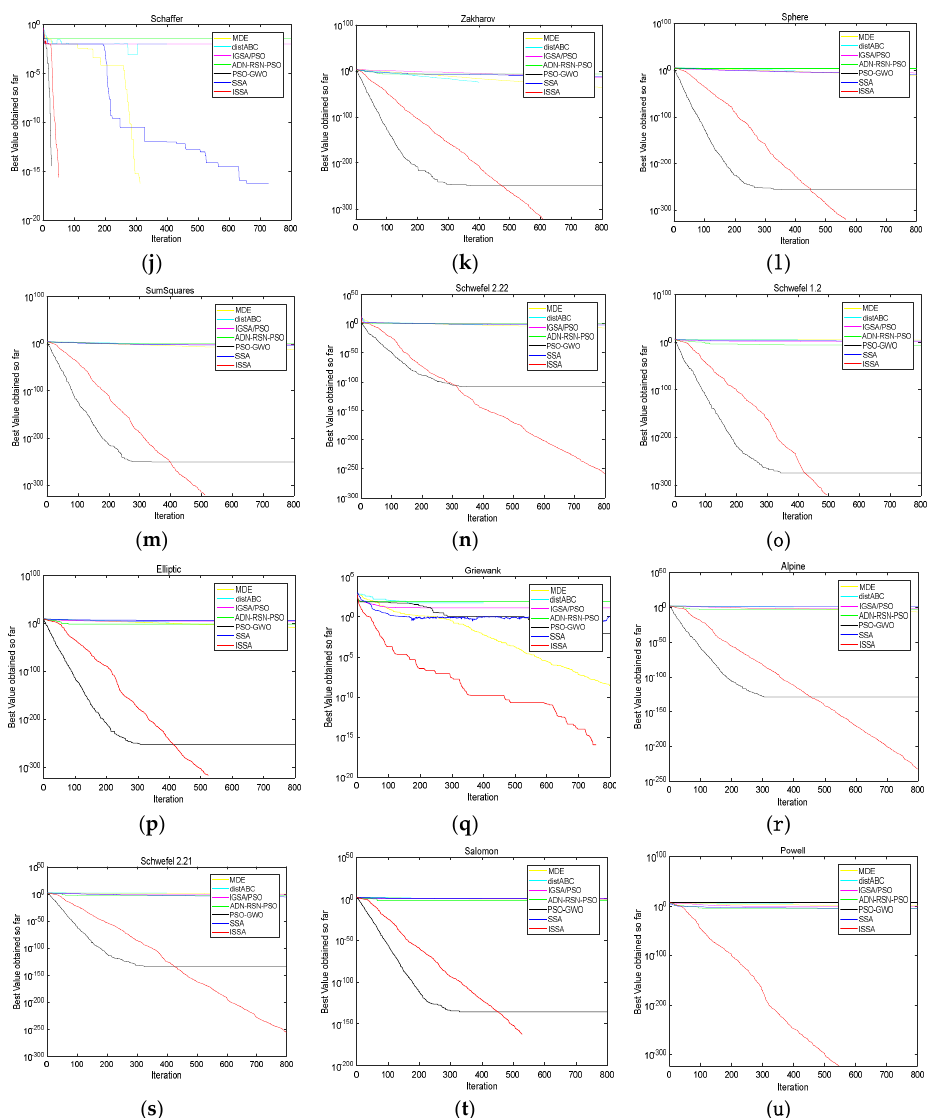
Figure 5. The convergence curves of ISSA and other algorithms .